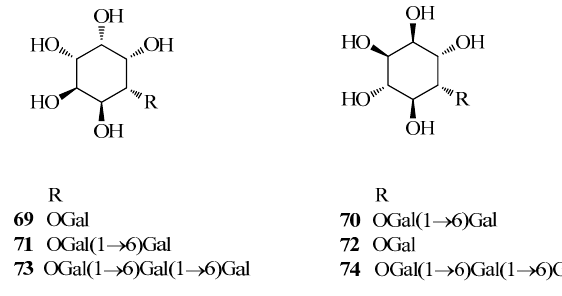
Figure 4. Structures of cyclitol compounds isolated from F. esculentum , F. tataricum and F. diabotrys .